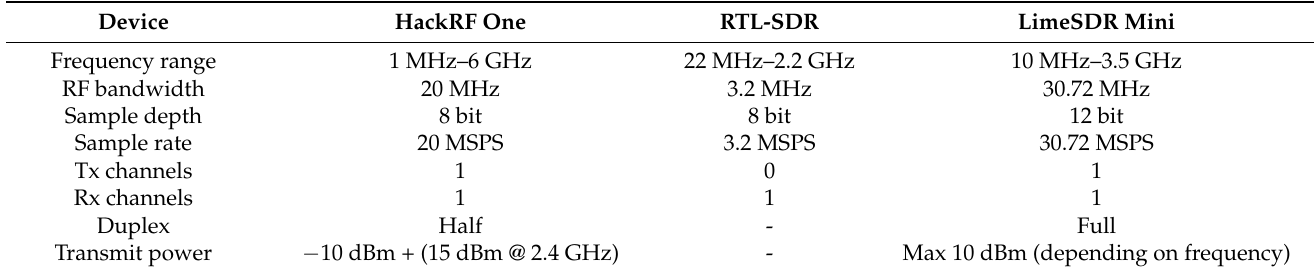
Table 1. SDR device characteristics [31], (MSPS, mega samples per second).